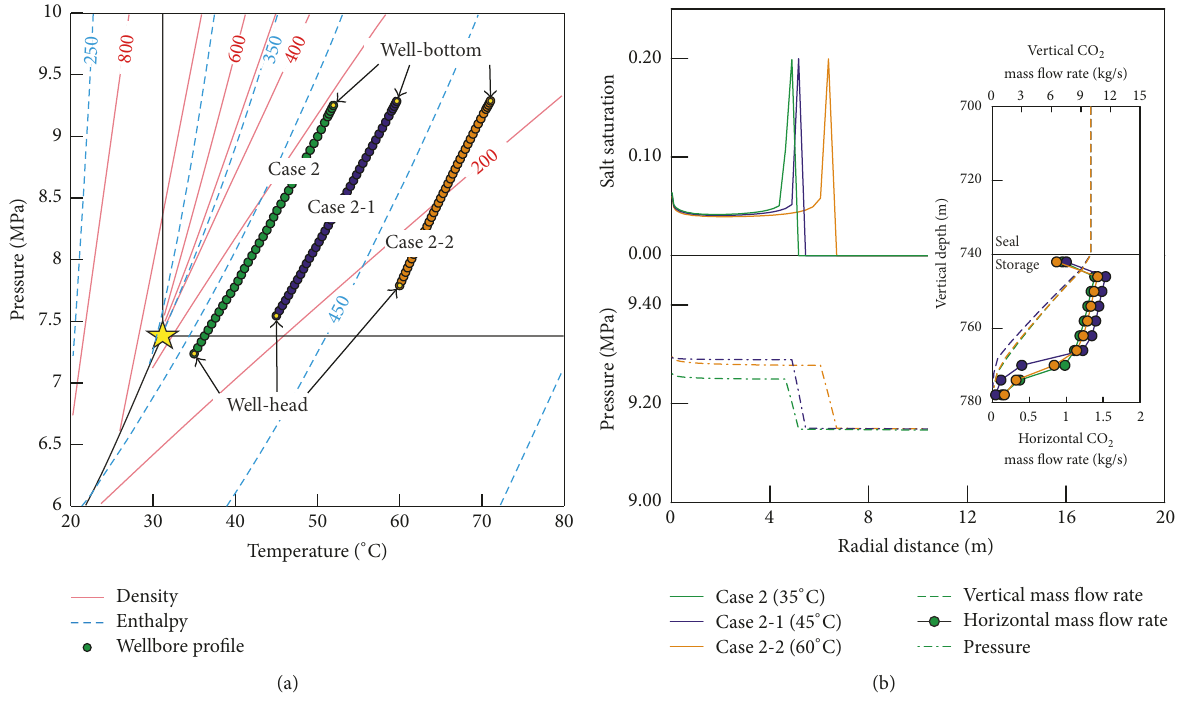
Figure 7: (a) Changes of CO 2 properties (density [kg/m 3 ] and enthalpy [kJ/kg]) within the wellbore and (b) development of salt saturation [-] and built-up pressure [MPa] at the bottom layer. The small figure represents both horizontal and vertical CO 2 mass flow rate [kg/s] within the wellbore at three different injection temperatures (35, 45, and 60 ∘ C) after 1,095